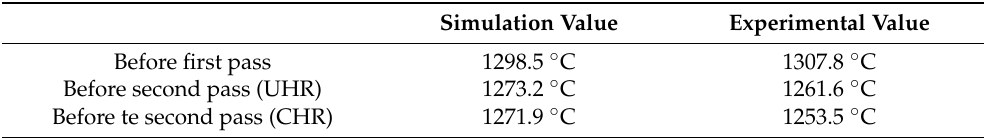
Figure 11. Comparison between theoretical and simulated rolling force under UHR and CHR processes. Table 3. Temperature comparison between measured and simulated values of plate surface under UHR and CHR